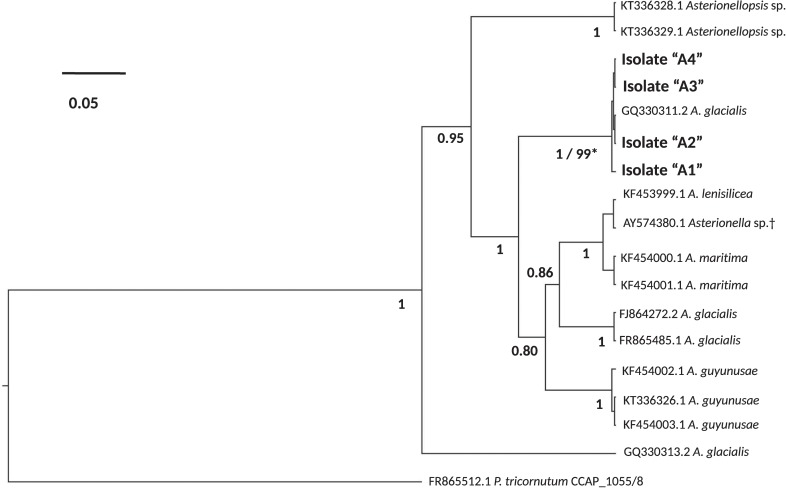
Phylogeny of the diatoms Asterionellopsis glacialis. A. glacialis Bayesian phylogeny was constructed using internal transcribed spacer 1 (ITS1), 5.8S rRNA gene and internal transcribed spacer 2 (ITS2) of four isolates (A1–A4). Main nodes are labeled with posterior probability values (0.0–1.0) and clade for our isolates is also supported by a maximum-likelihood (ML) bootstrap value (0–100). Scale bar represents nucleotide substitutions per site. †Current NCBI nomenclature. However, recent literature suggests erroneous naming in NCBI and prescribes assignment to the Asterionellopsis genus (Moniz and Kaczmarska, 2011).